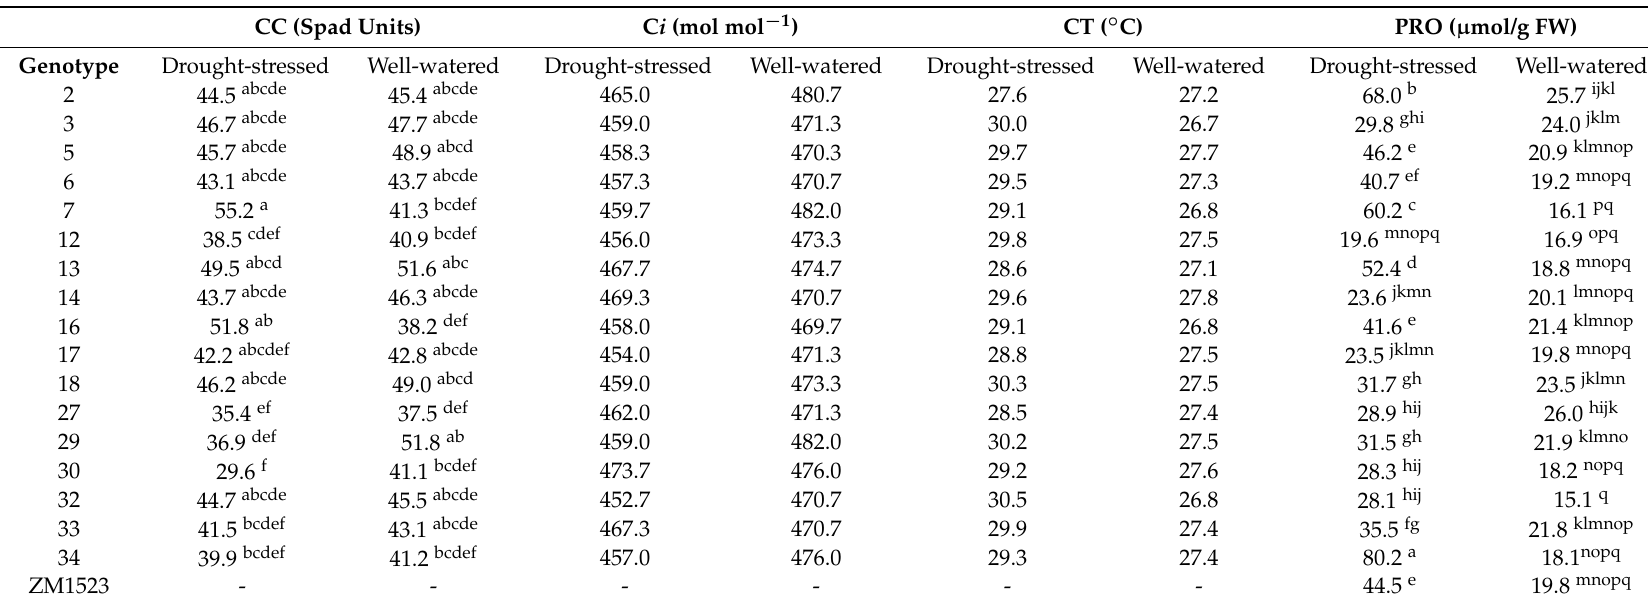
Table 3. Mean comparison among quality protein maize inbred lines based on chlorophyll content, substomatal CO 2 concentration, canopy temperature, and proline content under drought-stressed and well-watered